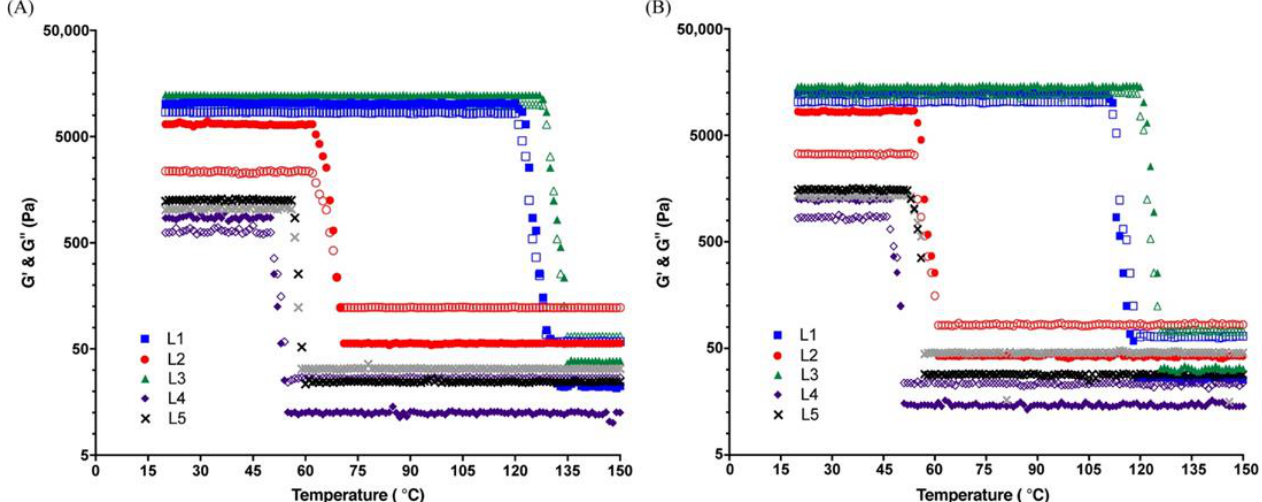
Figure 4. Temperature sweep experiments. Heating ( A ) and cooling ( B ) cycles for lipsticks L1 (blue squares), L2 (red circles), L3 (green triangles), L4 (purple diamonds) and L5 (black cross). Linear elastic (G′) and viscous (G″) moduli are shown as plain and open symbols, respectively. Each temperature ramp was performed with a heating rate of 1 °C min −1 , at a fixed angular frequency of 1 rad s −1 and a 1% strain within the LVR regime.